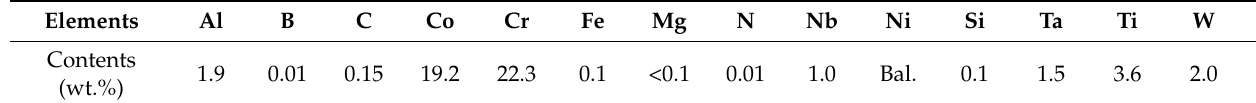
Table 1. Elemental composition of Inconel 939 powders.